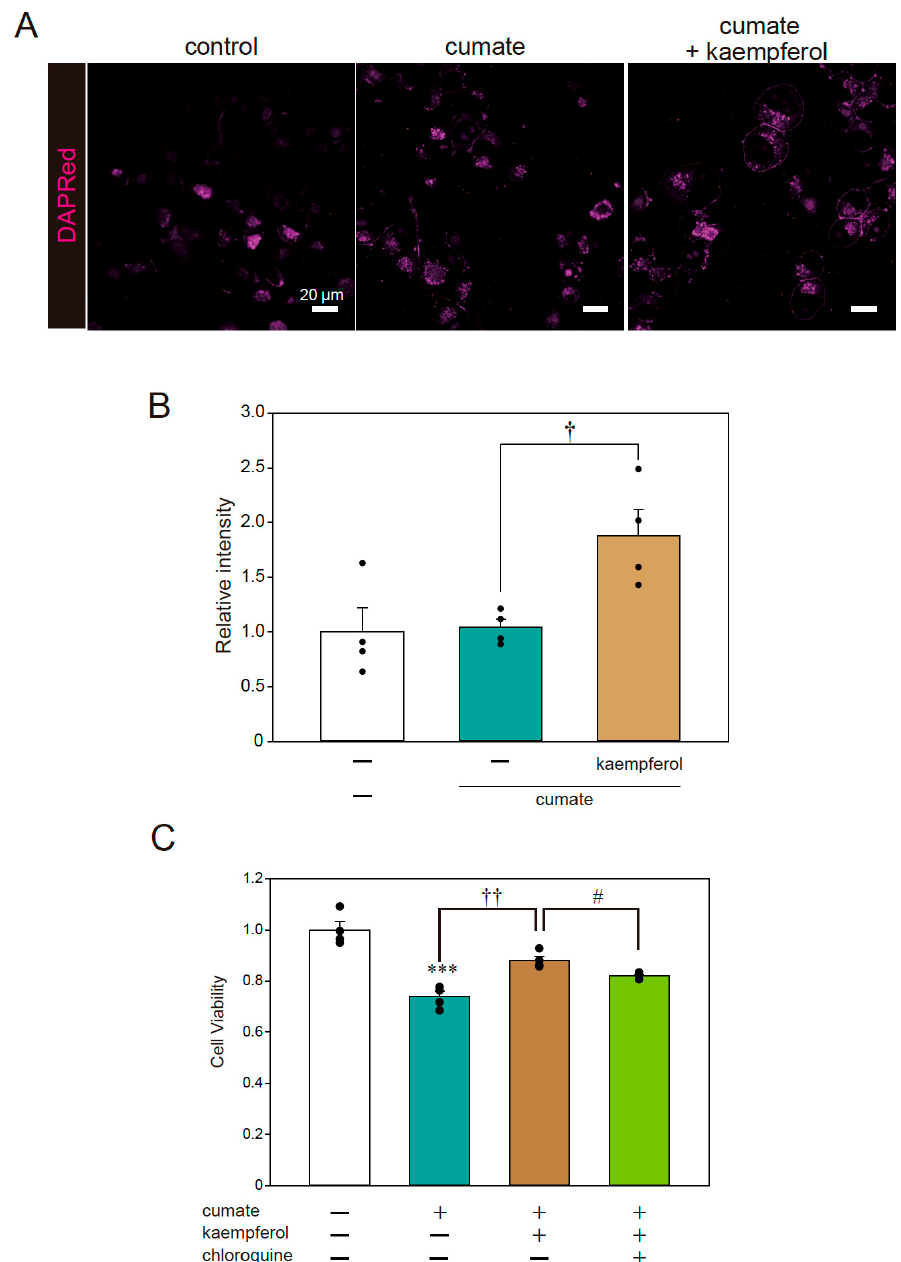
Figure 4. Kaempferol activated autophagy. α -Syn WT -N2a cells were treated with 5 µ M kaempferol